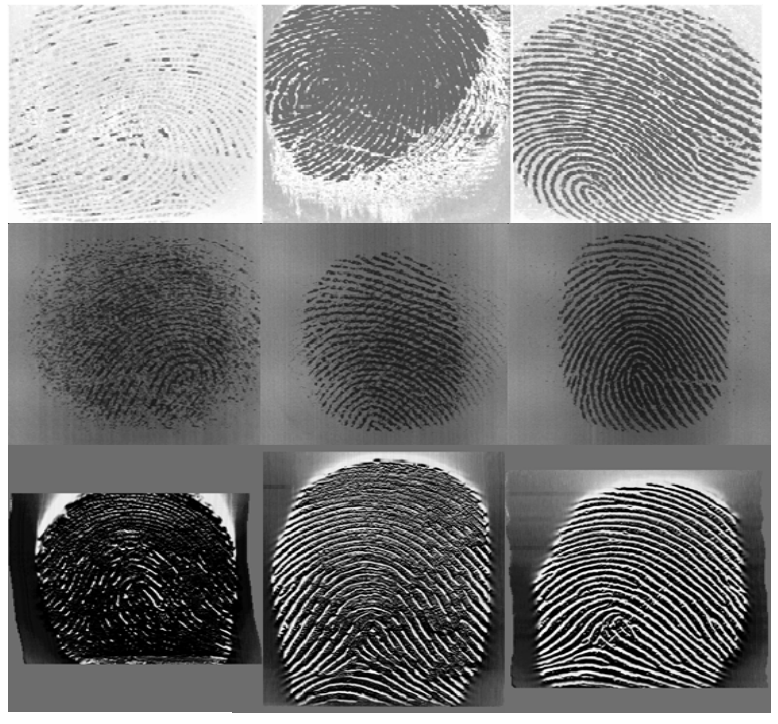
Figure 1. Fingerprint images from different capture sensors: (a) optical sensor, (b) capacitive sensor and (c) thermal